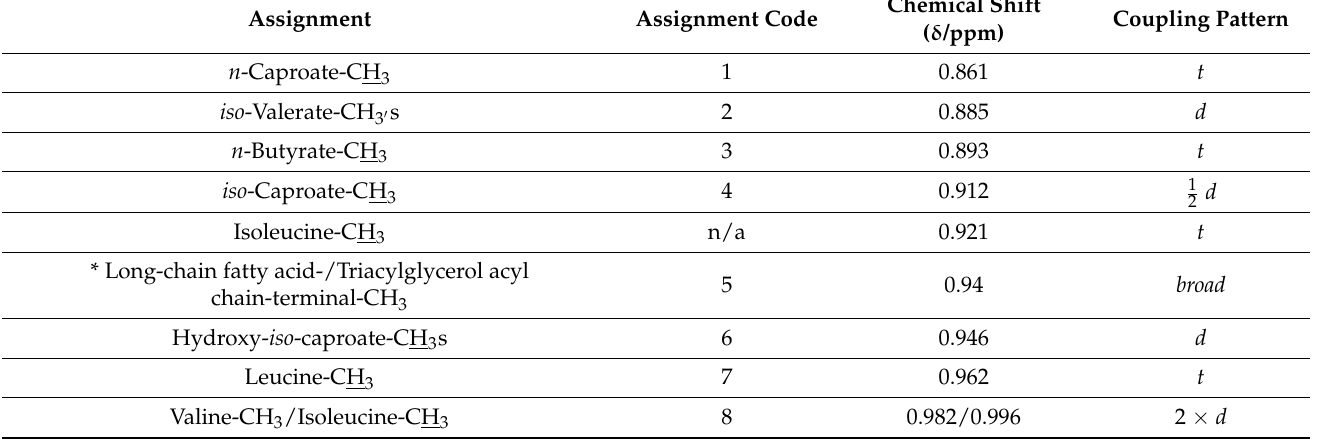
Table 1. Assignments of resonances in the 600 MHz 1 H NMR spectra of supernatants of WMS samples (chemical shift (ö) values and resonance coupling patterns are also provided). * Indicates tentative assignment. With the exception of the tentative ones indicated, assignments for the majority of these resonances were confirmed by (1) detailed considerations of chemical shift values, coupling patterns, and coupling constants; (2) comparisons with established literature and available database values (with allowances being made for the pH dependences of selected resonances, where required); (3) the application of the homonuclear two-dimensional (2D) COSY and TOCSY NMR techniques; and (4) standard addition treatments of WMSS samples with standard additions of standard solutions containing authentic, pure analytes, where considered appropriate. All chemical shift values were referenced to TSP ( δ = 0.00 ppm), but a further check on these was achieved by use of the WMSS sample -CH 3 group resonances of lactate ( δ = 1.330 ppm) and alanine ( δ = 1.486 ppm), and, hence, these served as secondary endogenous internal chemical shift